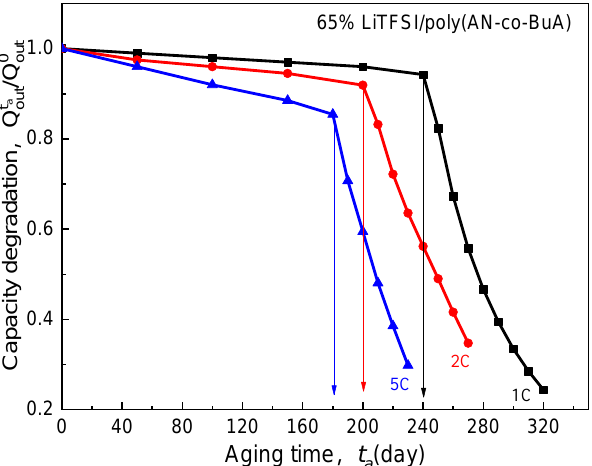
Figure 7. Effect of discharge rate on electrolyte-aging induced capacity degradation.